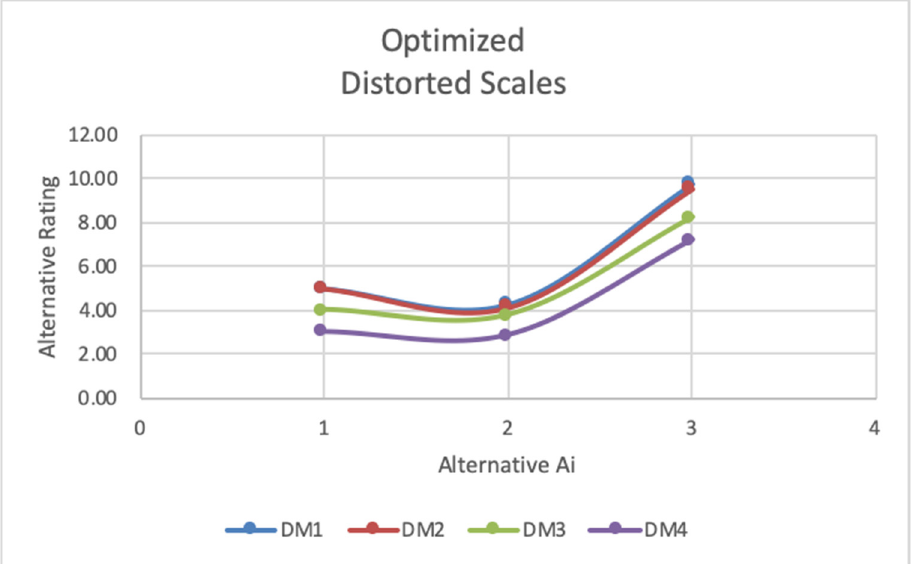
Figure 9. Case #11 adjusted distorted scales.